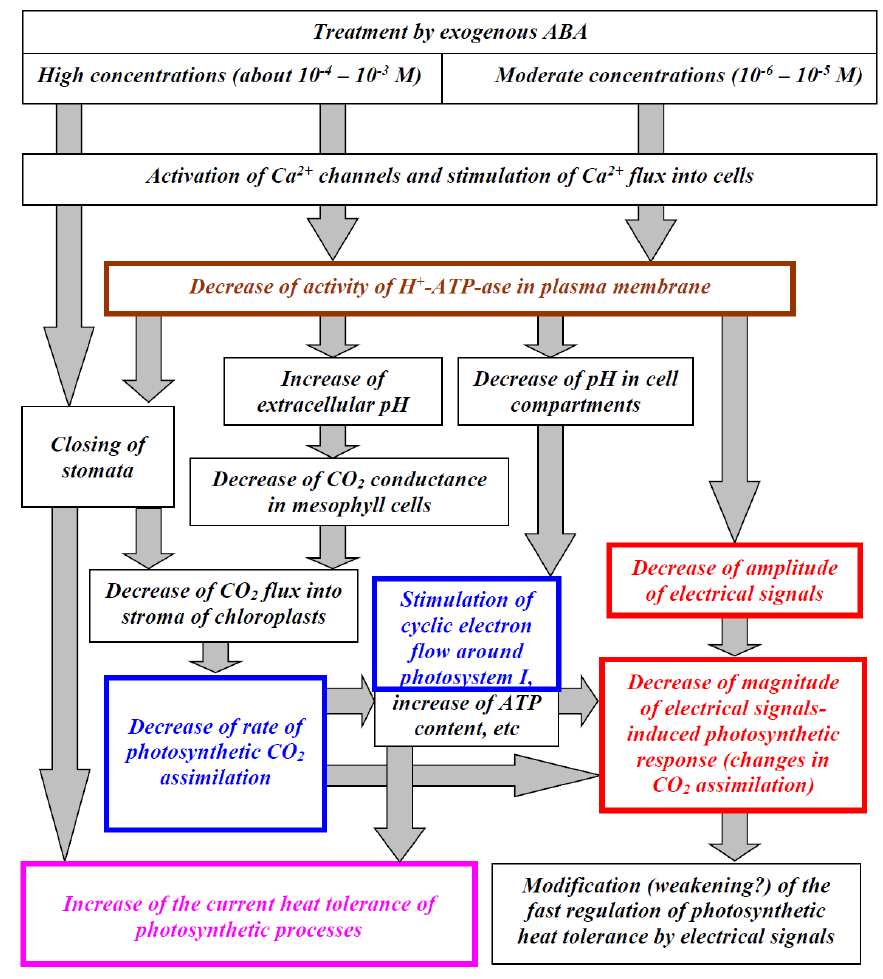
Figure 11. A hypothetical scheme of the potential modes of participation of the H + -ATP-ase of the plasma membrane in the influence of the spraying of plants with exogenous ABA on the photosynthetic CO 2 assimilation, heat tolerance of photosynthetic processes, and their regulation by electrical signals (see text for a detailed description). Colored boxes mark the results which are shown in the current work.